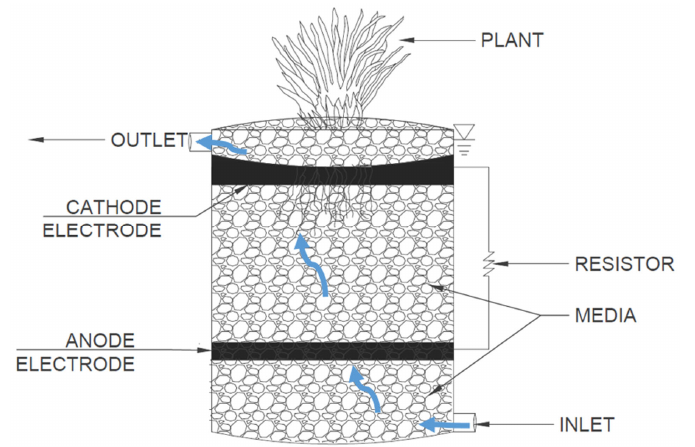
Figure 1. Representation of the major components of the CW ‐ MFC system.